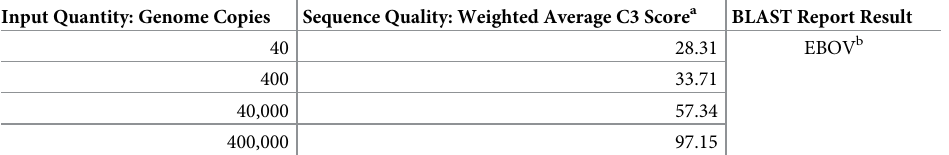
Table 2. Ebolavirus-RMA response to ebolavirus quantity. Ebola virus Mayinga isolate (NR-31806, BEI Resources) RNA quantity was serially diluted